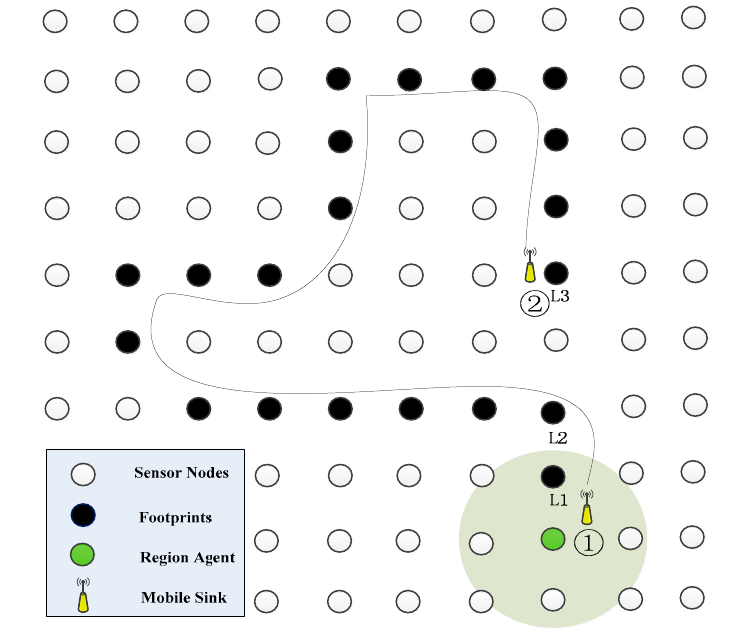
Figure 1. A typical scenario for DAMST.